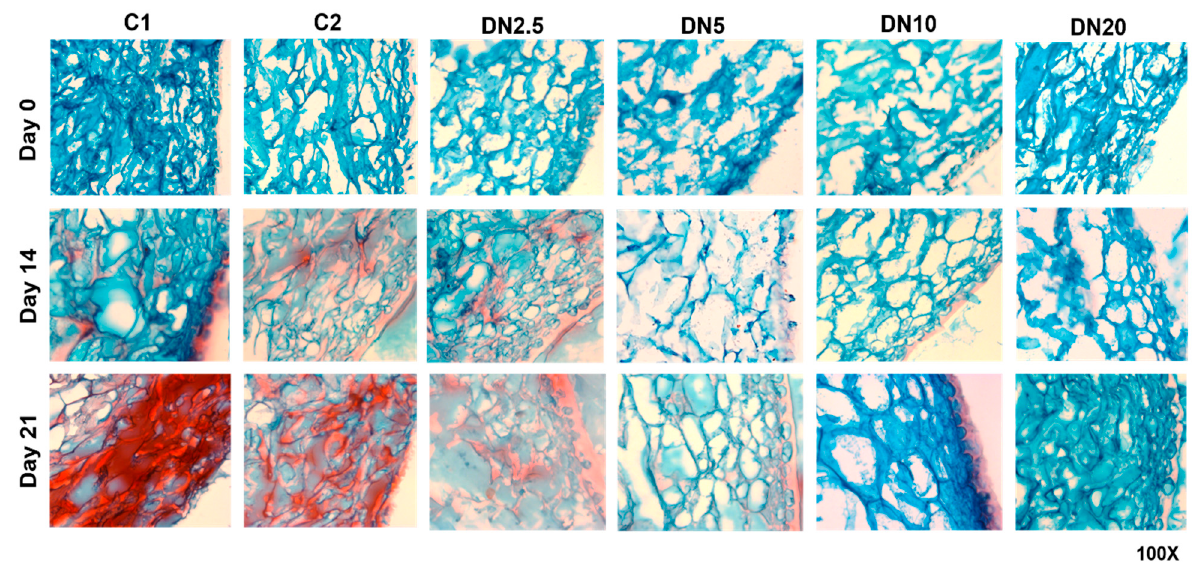
Figure 4. HIstological evaluation of the pericarp of tomato fruits coated with nanoemulsion during storage. The columns indicate the different treatment (Whitout coating (C1); only with coating of mineral oil suitable for food (C2); with the nanoemulsion that was diluted to 2.5% (DN2.5), 5% (DN5), 10% (DN10), and 20% (DN20) in the mineral oil suitable for food use) and the rows indicate the different days of analysis (0, 14, and 21 days).